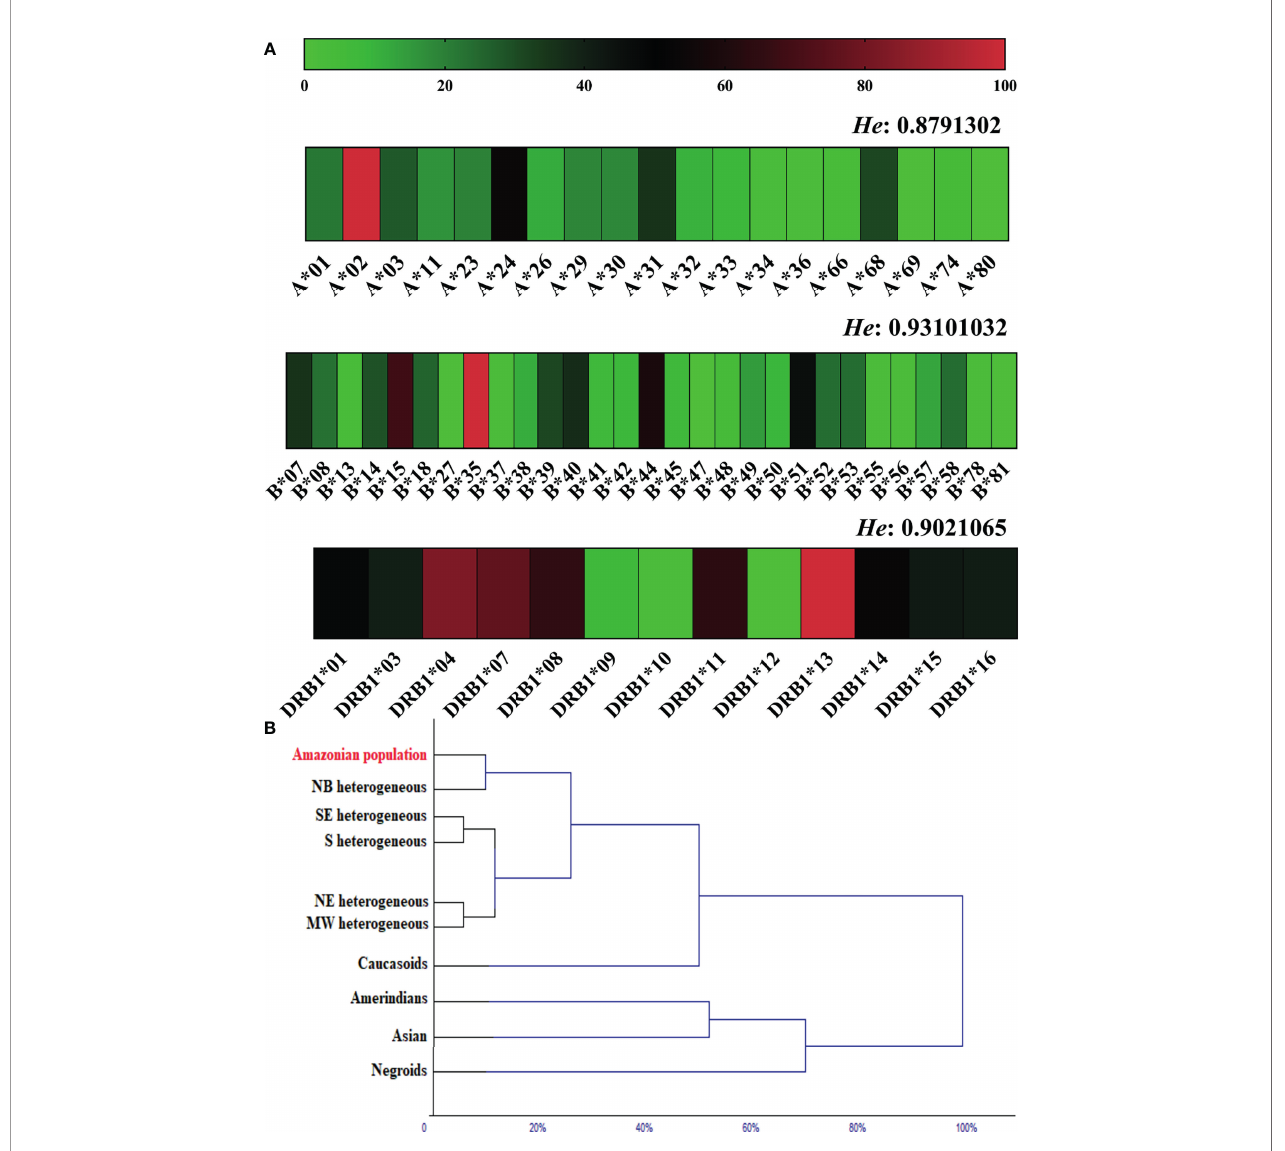
FIGURE 2 | (A) Heatmap of the allelic frequency and expected heterozygosity ( He ) of loci A, B and DRB1 in the general population. (B) Dendrogram of the multivariate cluster analysis showing proximity due to allele frequency similarity of the studied population (Amazonian population) with other ethnic groups. NB, Northern Brazil; NE, Northeast Brazil; MW, Brazilian Midwest; SE, Southeast Brazil; S, Southern